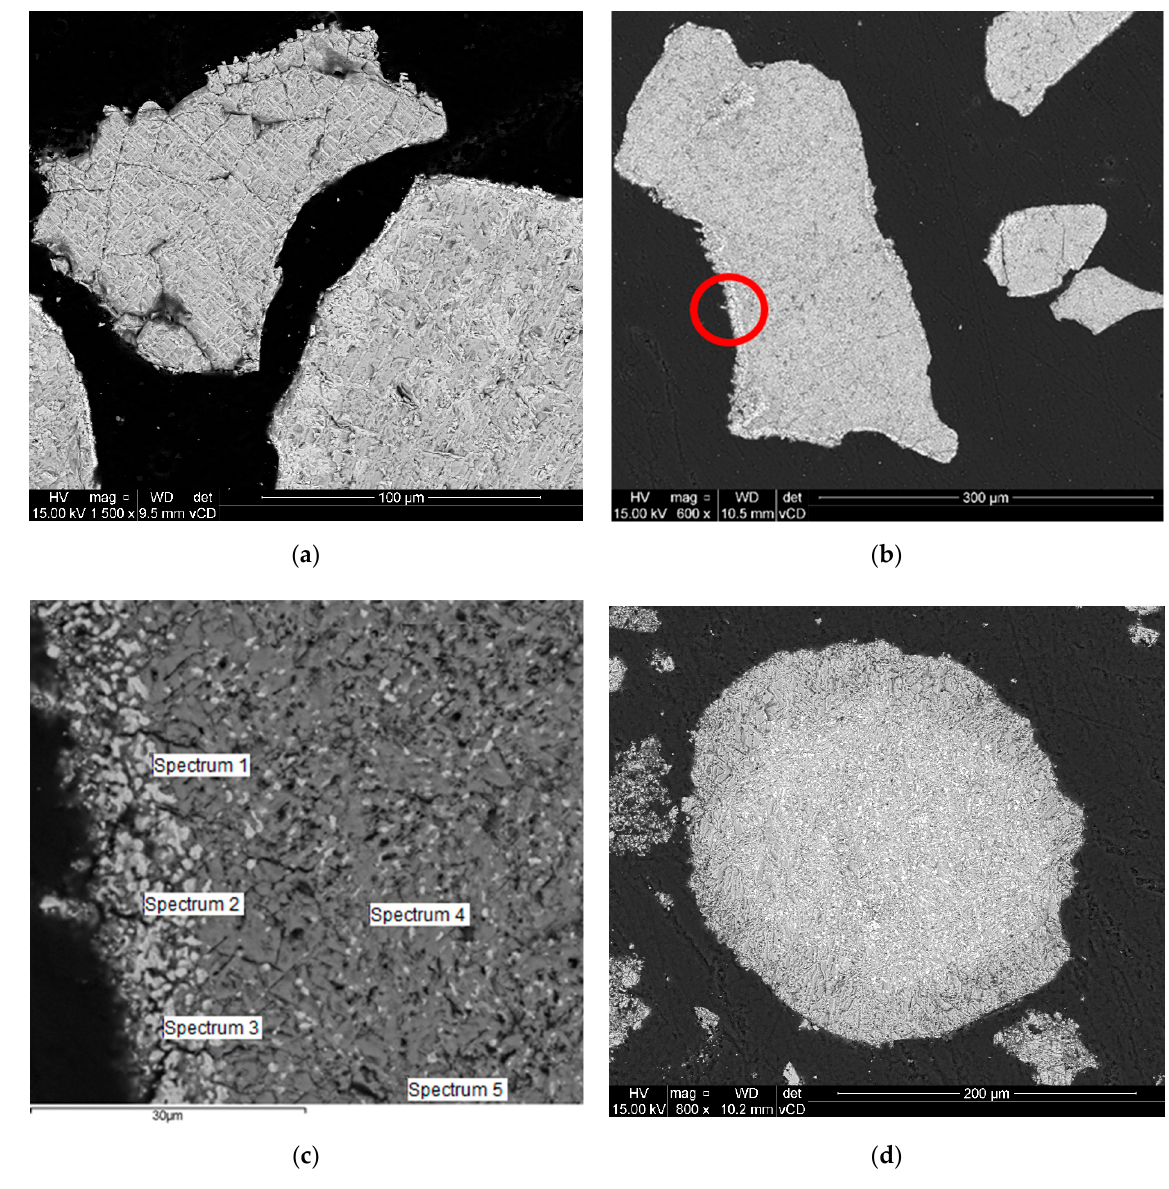
Figure 10. Backscattered electron SEM micrograph of chromite particles pre-oxidized at 1100 °C for 60 min ( a ) and subsequently reduced at 1100 °C for 60 min at a hydrogen flow rate of 750 mL/min ( b , c ) presents a similar particle as shown in ( b ) at a higher magnification (encircled) and ( d ) a pre-oxidized/reduced particle after leaching.